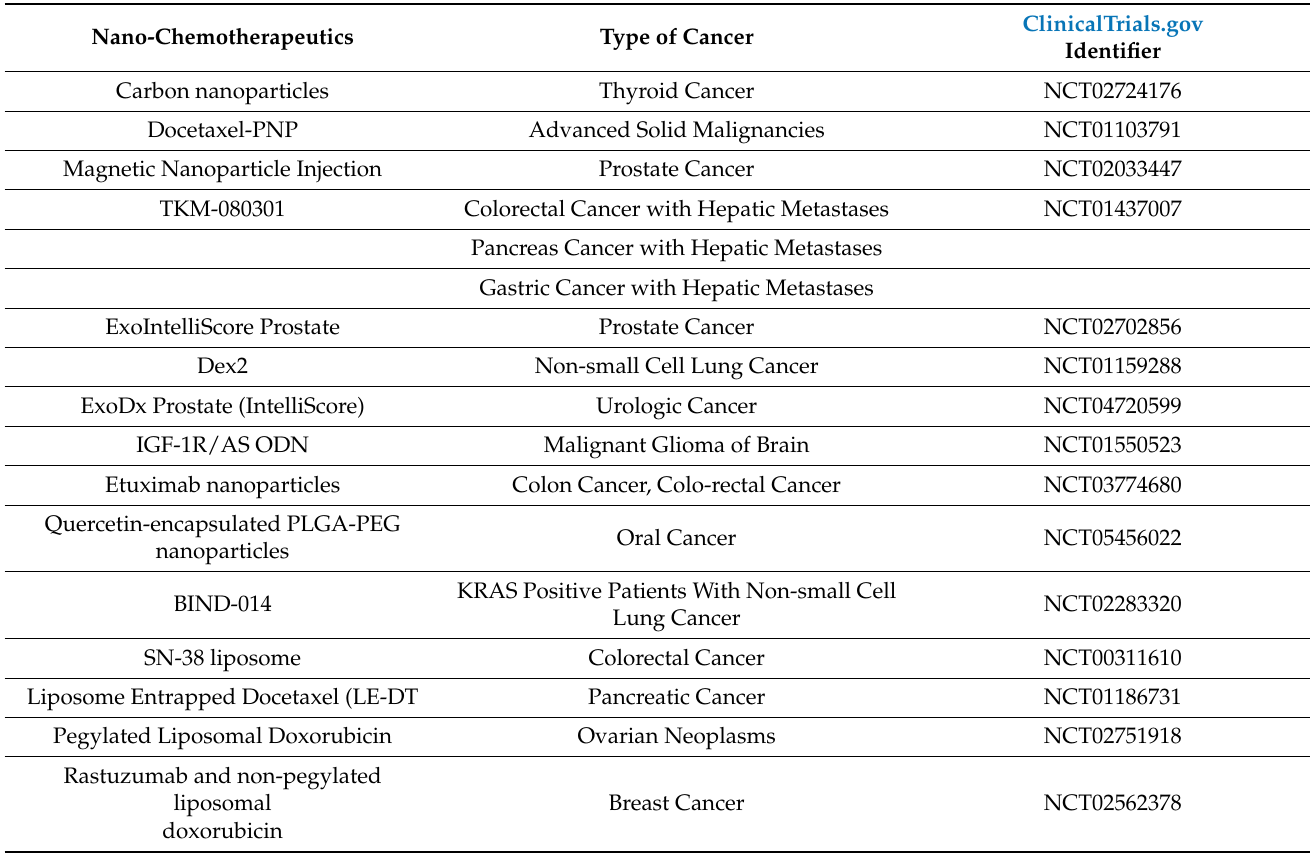
Table 5. Nanotechnology-based treatment approaches for cancer in clinical